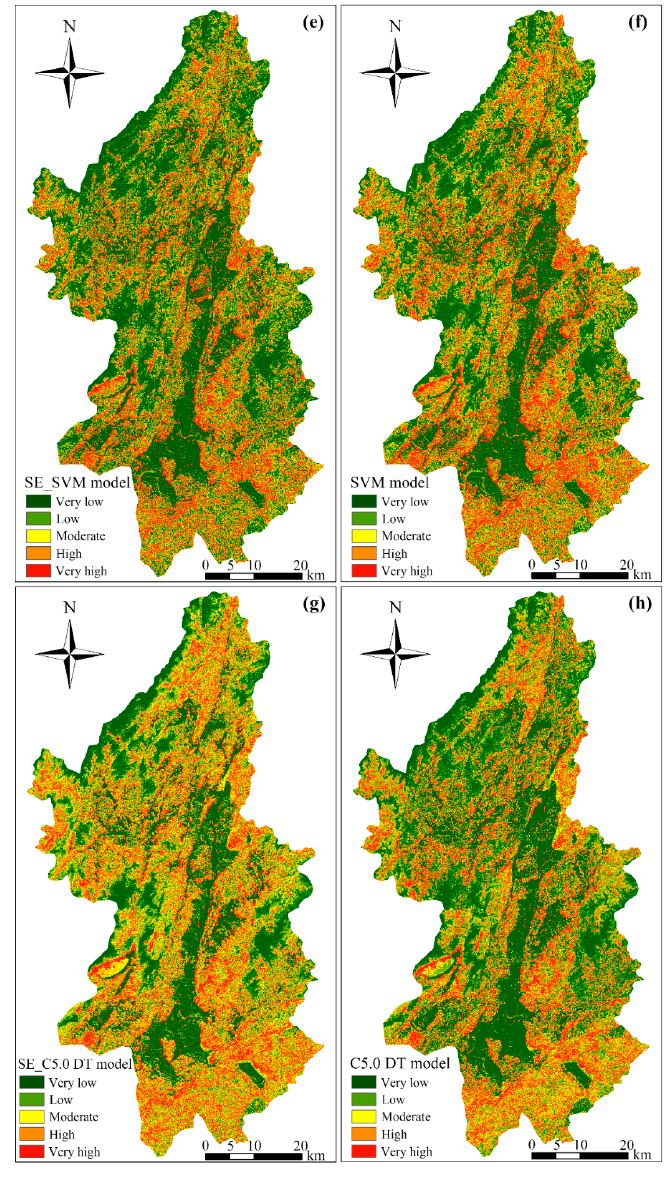
Figure 6. LSMs of each model with 60 m grid resolutions: ( a ) SE_MLP model; ( b ) MLP model; ( c ) SE_LR model; ( d ) LR model; ( e ) SE_SVM model; ( f ) SVM model; ( g ) SE_C 5.0 DT model; ( h ) C 5.0 DT model